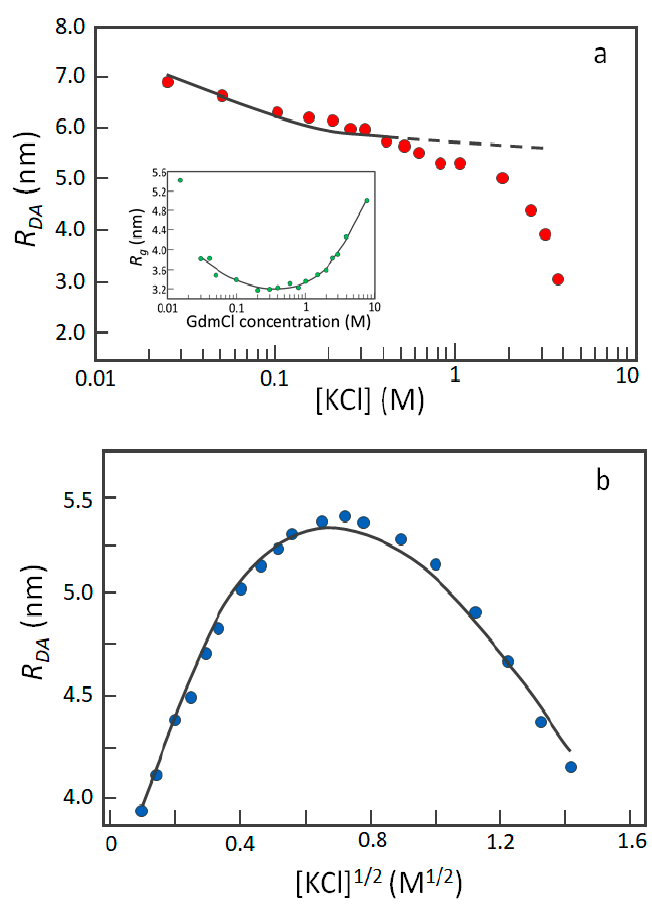
Figure 3. Dependence of IDP compaction on salt concentration. The end-to-end distance obtained from single-molecule Förster resonance energy transfer (smFRET) is expressed as donor-acceptor distances ( R DA ) vs. KCl concentration. ( a ) The uniformly charged polyelectrolyte Sic1 undergoes collapse, due to shielding of unbalanced electrostatic charges and attenuation of their repulsive forces. The black solid line represents the fitting by the model described in [55]. At higher KCl concentrations, hydrophobic interactions are likely to overlap with the charge screening effect. The inset shows the behavior of Sic1 R g exposed to GdmCl. Here, non-chaotropic concentrations (<1 M) cause protein collapse, while higher denaturing concentrations lead to conformational swelling [55], conferring a non-monotonic behavior significantly different from the main plot of panel ( a ). Figures adapted from [55]. ( b ) The polyampholyte Myc undergoes expansion due to the weakening of attractive electrostatic forces at a low KCl concentration (<0.6 M). Here the R DA is plotted versus [KCl] ½ to allow fitting of the experimental results by the polyampholyte theory [56]. The dependence of size is modelled on the root square of the ionic strength, which corresponds to the root square of the concentration for a completely dissociated mono-ionic salt. At higher concentrations, the chain collapses again, probably due to the prevalence of hydrophobic interactions over charge shielding. The black solid line represents the fitting by the model described in [56]. Figure adapted from [56].